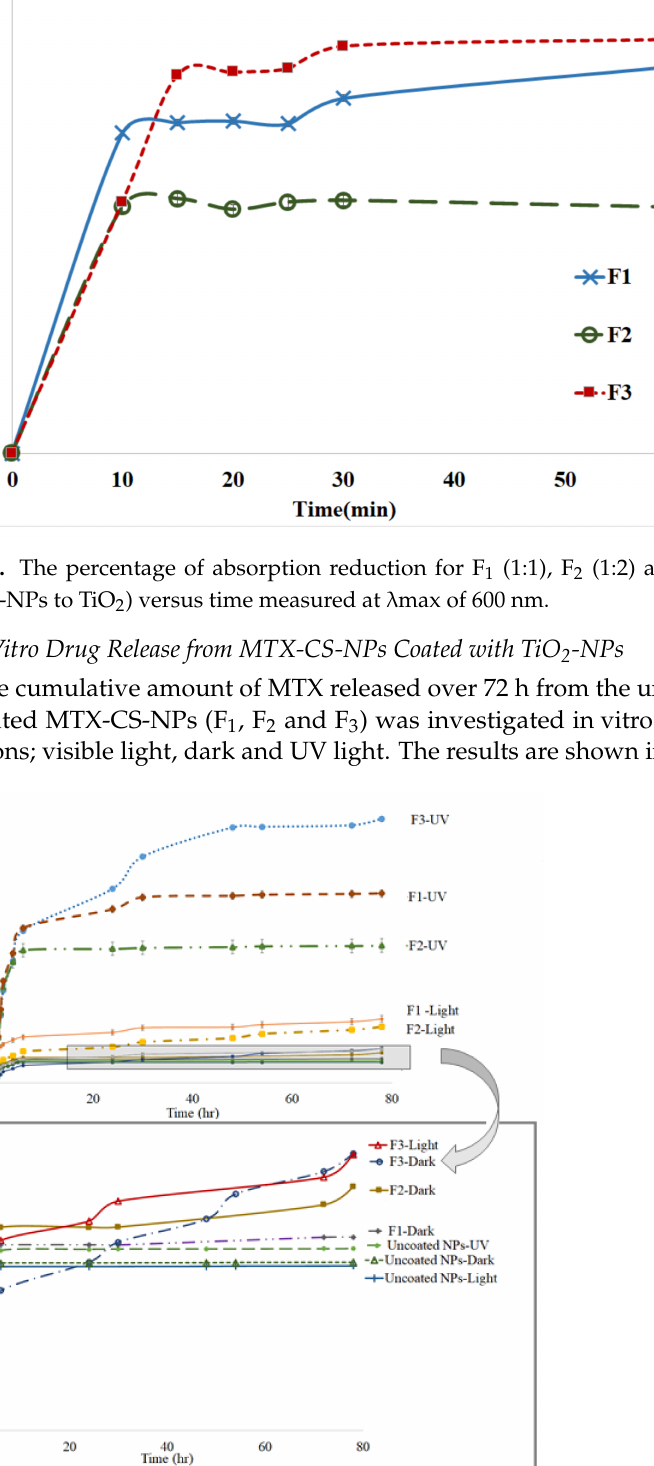
Figure 5. The cumulative amount of MTX released over 72 h from the uncoated MTX-CS-NPs, F 1 (1:1), F 2 (1:2) and F 3 (2:1) (the ratio of MTX-CS-NPs to TiO 2 ) in vitro under three different conditions: visible light, dark and UV